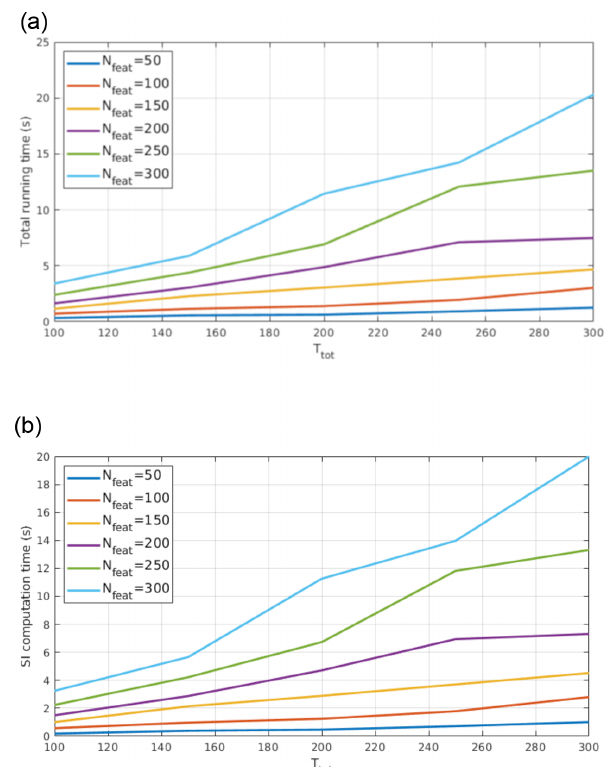
Figure 15. CoI computational time (a) and SI computational time (b) as functions of training set size ( T tot ) and of the number of features used ( N feat ). A non-linear relationship between the vari- ables is